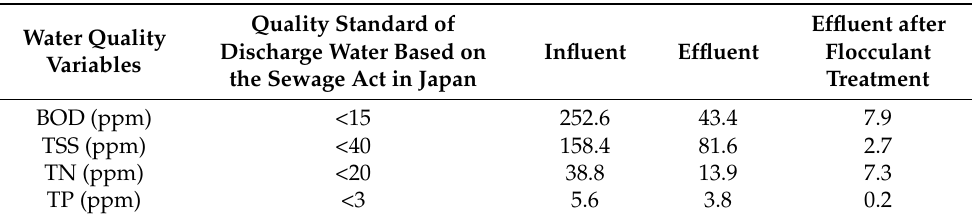
Table 5. Nutrient removal in primarily treated sewage polyculture with 0.8 m culture depth (esti- mated from the figure of water quality test